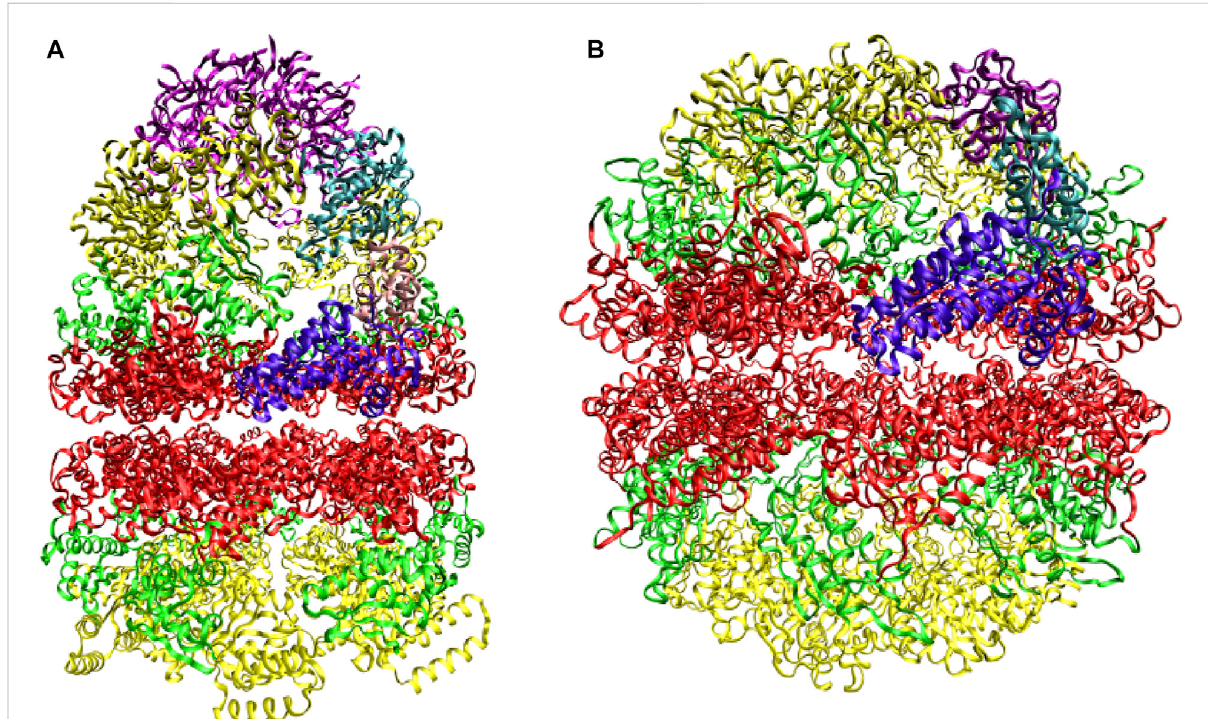
FIGURE 1 Prototypes of chaperonin classes. (A) Group I chaperonin GroEL and its co-chaperonin GroES (purple) (B) Group II chaperonin thermosome. Three domains, equatorial (red), intermediate (green), and apical (yellow), are distinguished within each subunit. The domains belonging to one subunit of each chaperonin are higlighted. Adapted from (Ditzel et al.,